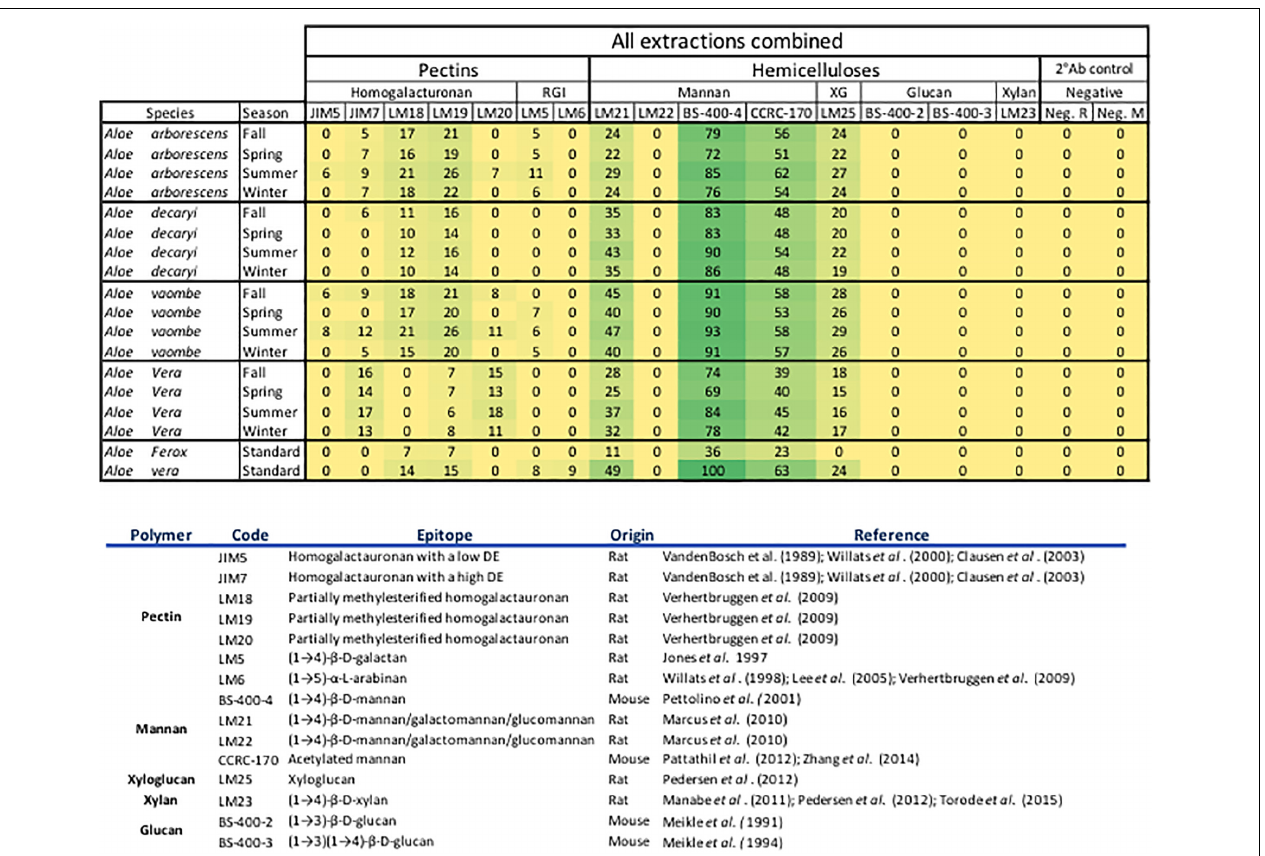
FIGURE 2 | All extractions are summarized per season. The Ph. Eur. Material extractions (standards) are also summarized for each species. All tested antibodies are included. Included antibodies and their target epitope as well as the origin of the antibody and where their bindings have been described is listed below the heatmap. DE, degree of esterification; RGl, rhamno-galacturonan; KG, kyloglycan; Neg. R, anti-rat; Neg. M, anti-mouse. The highest mean value of the entire dataset was assigned the value of 100%, and the remainder of the data were adjusted accordingly and normalized with a 5% cut off (represented with a zero – “0”).